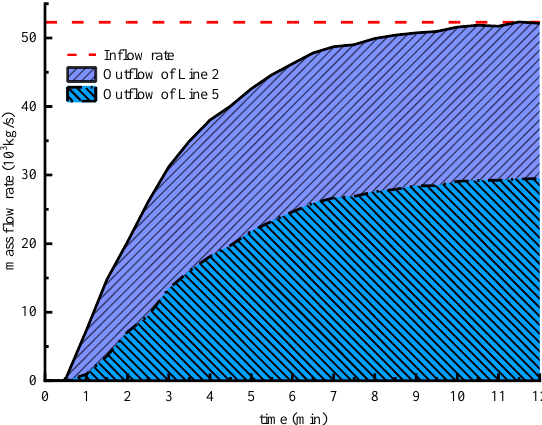
Figure 16. Flood inflow and outflow relationship diagram.